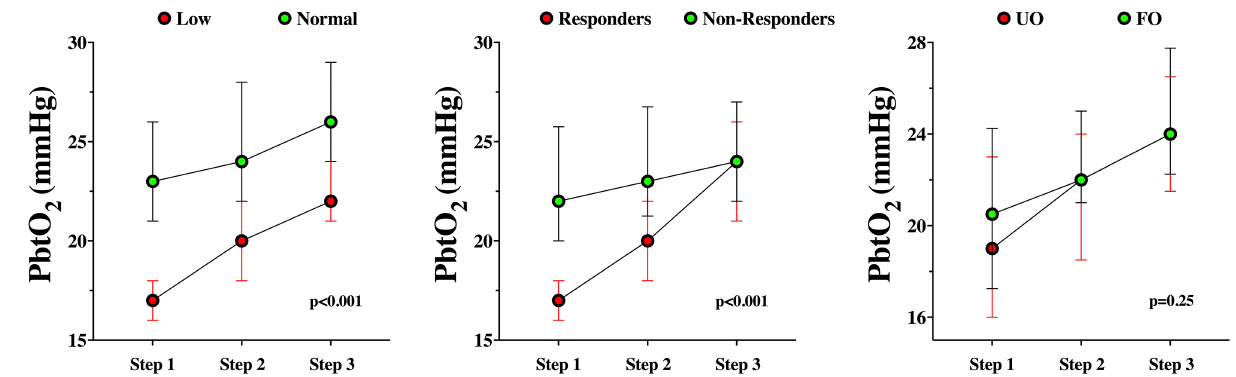
A total of 19 (56%), 10 (42%), 4 (36%), and 3 (43%) were PbtO 2 responders during the CPP challenge on days 2, 3, 4, and 5, respectively. A total of 18 (53%), 12 (50%), 4 (36%), and 3